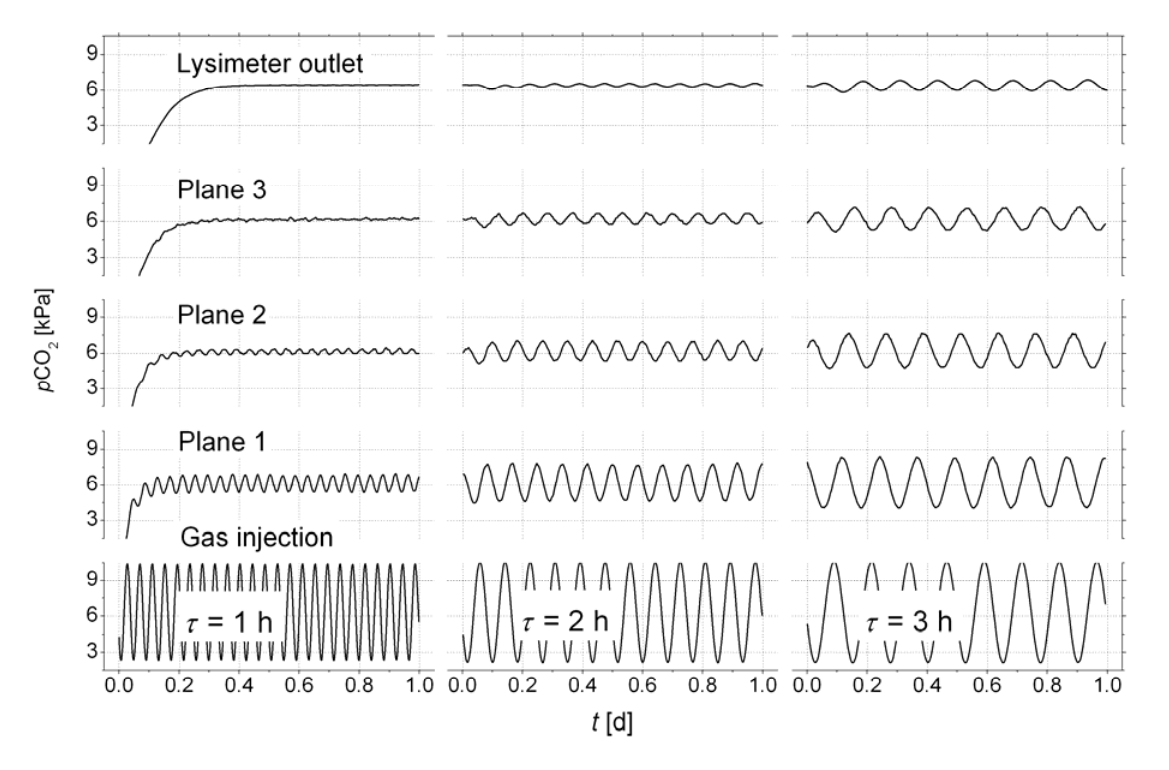
Figure 4. Convective-dispersive propagation of oscillating pCO (mixtures with dry air) inside the